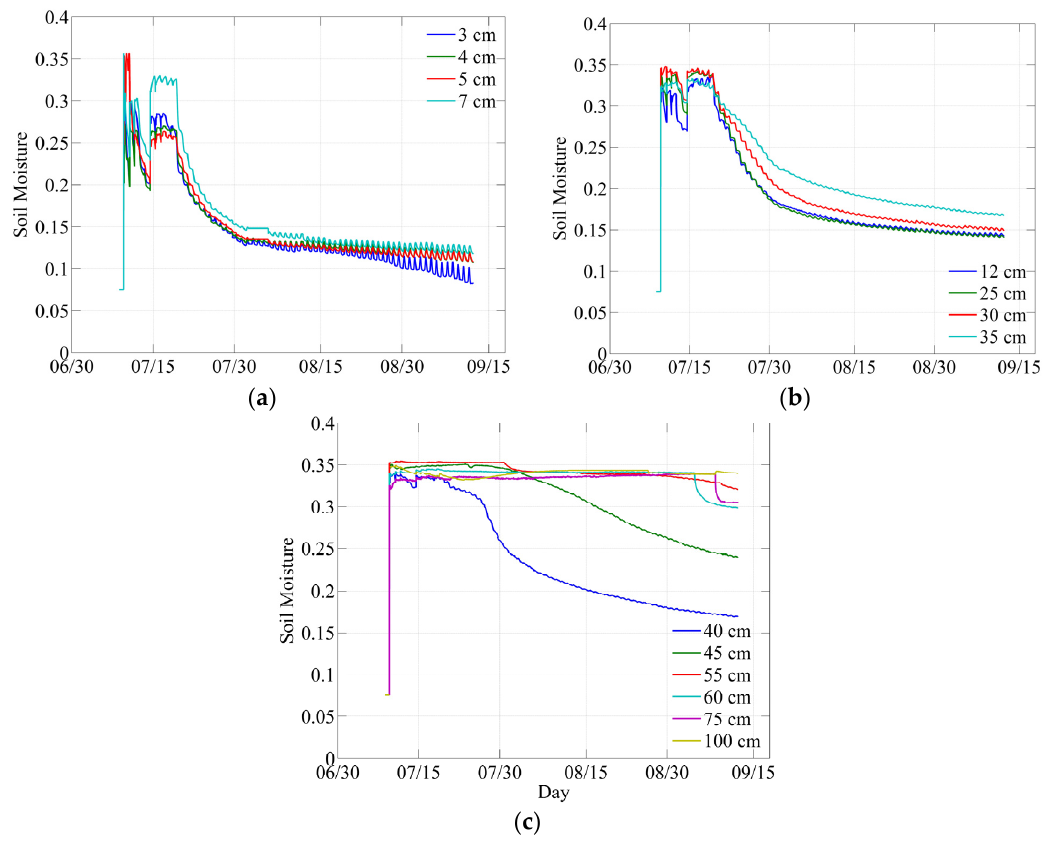
Figure 6. Soil moisture content variations recorded by sensors ( a ) from 3 to 7 cm of depth; ( b ) 12 to 35 cm of depth; and ( c ) from 40 to 100 cm of depth.